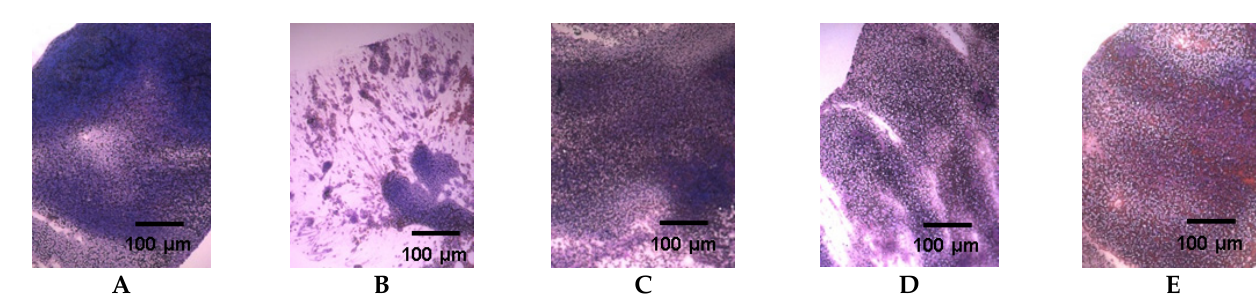
Figure 4. The level of IL-6 in blood of mice with CPh-induced immunosuppression after treatment with recombinant granulocyte colony-stimulating factor (r G-CSF), chondroitin sulfate ( CS ) and fu-